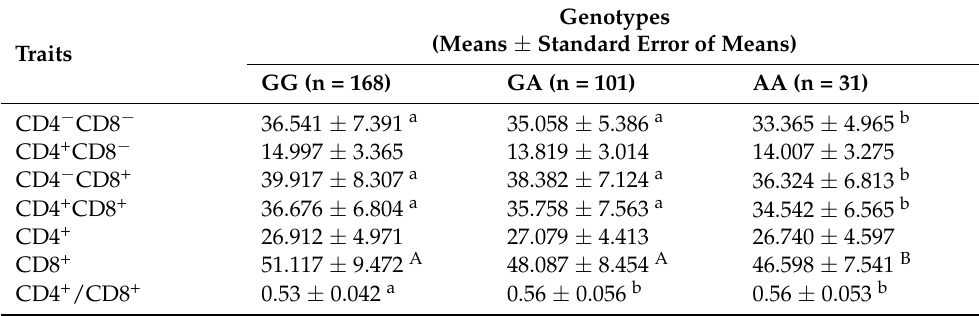
Genotypes (Means ± Standard Error of